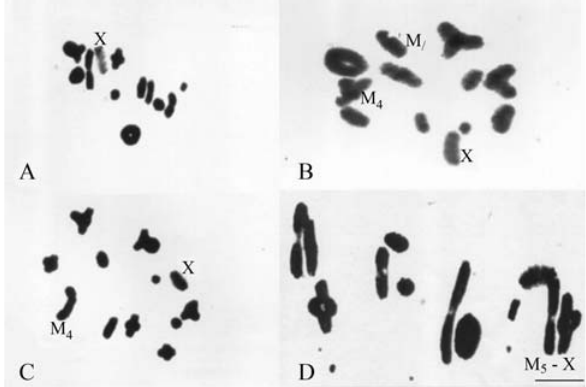
Figure 1 - A- Metaphase I of the standard karyotype of Sinipta dalmani . B- Metaphase I of a double heterozygote for a pericentric inversions in pairs M4 and M7. C- Metaphase I of a M4 inversion homozygote. D- Metaphase I of a heterozygote for the centric fusion showing the neoXY bivalent (M5-X). Bar: 10 μ